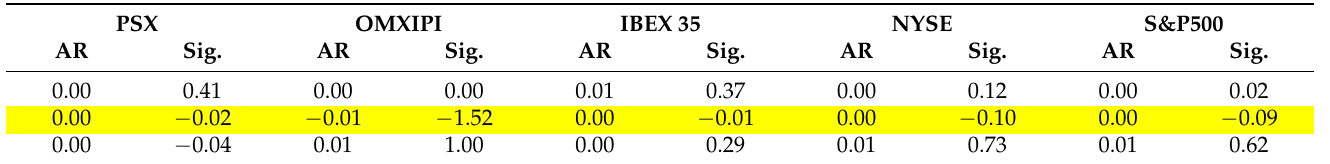
Table A37. Abnormal returns of the ( − 1, +1) event window (Resignation of D. Jos é Manuel Soria, Spain’s Minister of Industry).